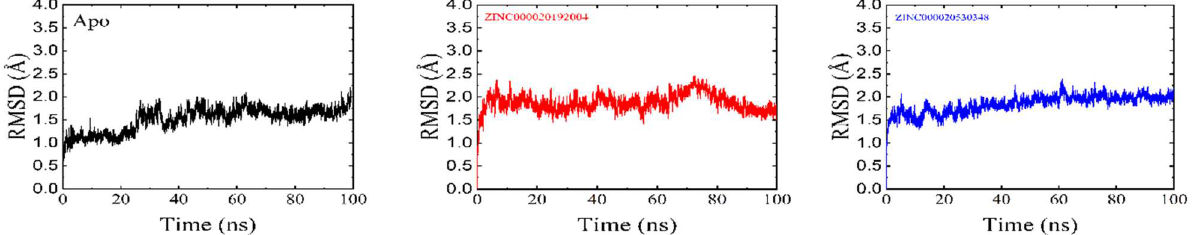
Figure 7. RMSD of apostate (black color) and the ZINC000020192004 and ZINC000020530348. The average RoG values of 16.2, 16.1, and 16.01 were observed for ZINC000020192004 and ZINC000020530348, and the apo-enzyme. The RMSF measures how the residues fluctuate when bound to a drug [43]. An increase in the RMSF value indicates an increase in the flexibility of the alpha-carbon atoms. Compared to the two predicted hits, the more flexible regions were found in the apo-enzyme. High residual fluctuations were recorded at residues 20–40 and 60–80, as shown in Figure 8.